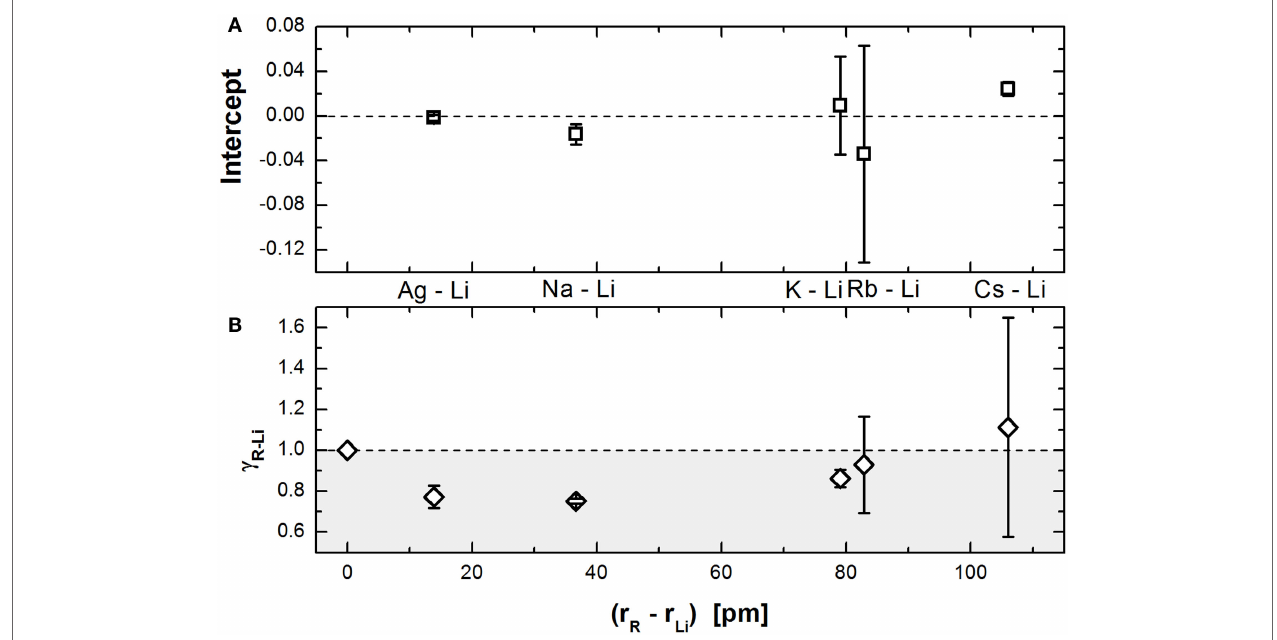
FIGURE 2 | Parameters of the linear regressions [intercept (A) and slope γγγ (B)] shown in Figure 1 plotted as a function of the difference between the radius of the modifier R and Li